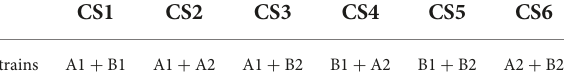
TABLE 3 Hg speciation on study soils (Millán et al., 2007). Soil Total Hg Soluble Hg Exchangeable (mg/Kg) (mg/Kg) Hg